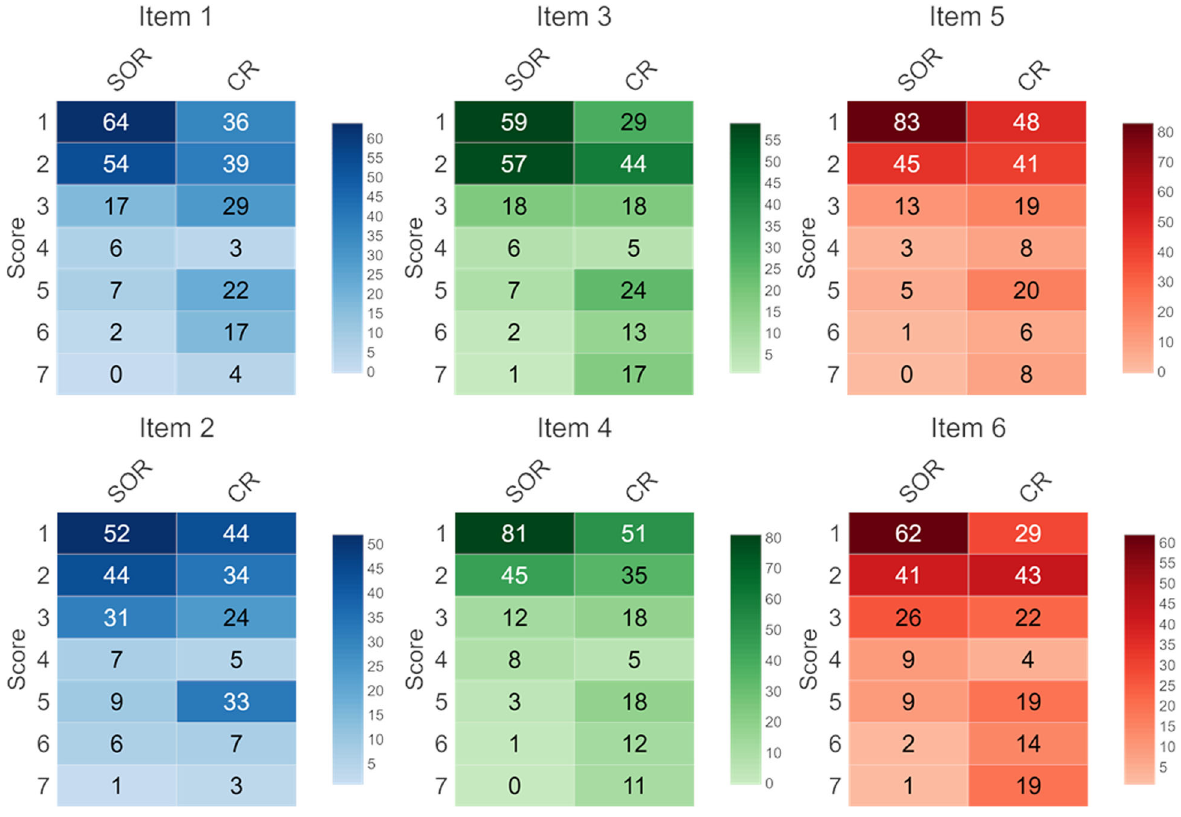
Fig. 4 Heatmaps of score distribution for questionnaire items. Numbers in boxes indicate numbers of ratings per score considering all observers. SOR, structured oncology reports; CR, conventional